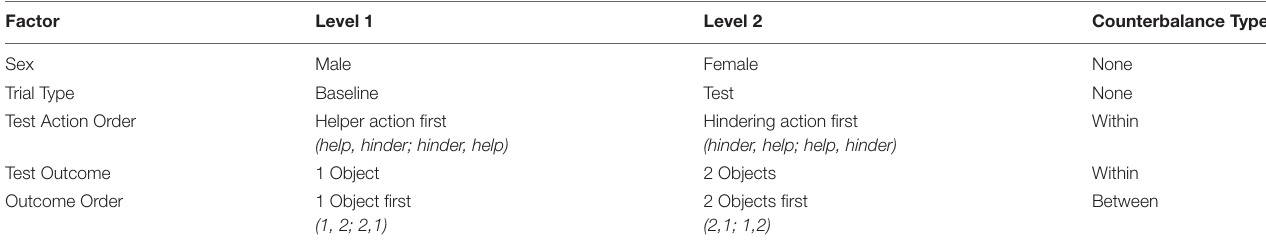
events and to help facilitate encoding of the sequence of actions that would be seen in the subsequent test phase. At the start of the event the Protagonist puppet entered the stage from the left corner and moved to one side of the box, which was positioned in the center of the stage. The puppet leaned down to look inside the box three times and then attempted to open the box four times by pulling on the corner of the box’s lid. On the first two attempts it pulled up, lifted the edge of the box a few inches, and dropped it back down. On the third and fourth attempts, it lifted the edge of the lid and lowered it while continuously holding onto the lid, as if the lid was too heavy for it to open. On the fifth attempt, a Pig puppet moved out from behind the opaque screen that was positioned on the right side of the stage, and moved forward next to the box. What happened next was determined by whether it was a Helping or Hindering trial. During the Helping trial, the Pig puppet grasped the front right corner of the box, and both the Pig and Protagonist